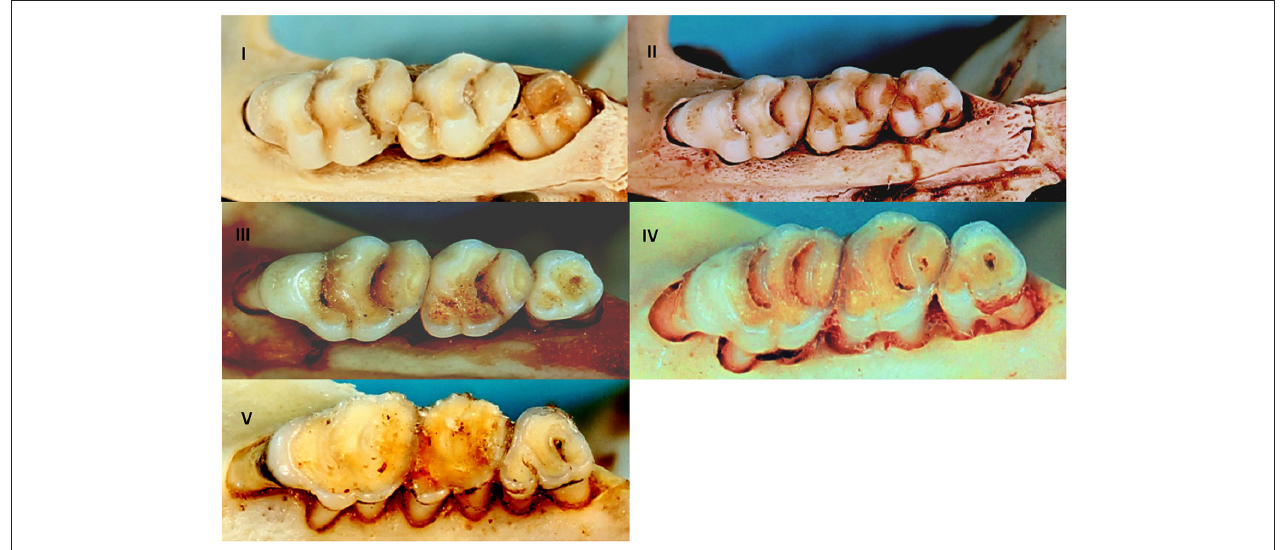
FIGURE 2 | Relative age classes I–V in R. norvegicus representing relative age classes in invasive and indigenous commensal, murid rodents from Gauteng Province, South Africa based on the degree of tooth wear of the upper molar tooth row.